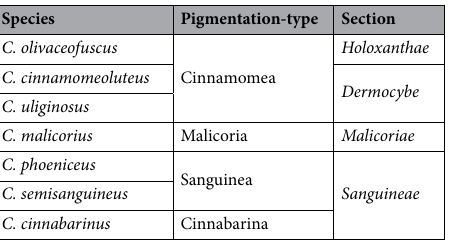
Table 1. Selected representatives of the dermocyboid Cortinarii sorted according to their pigmentation type and section.